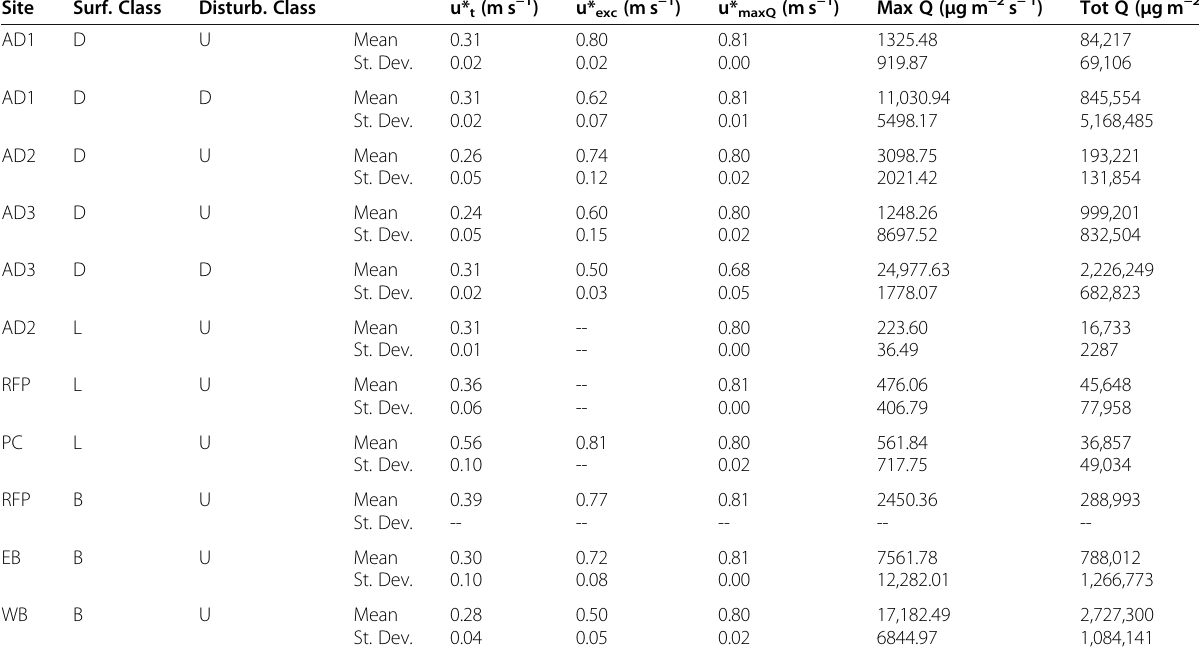
Table 3 Surface class (Delta, Lake, or Beach), disturbance class (Undisturbed or Disturbed), and mean and standard deviation of threshold friction velocity (u* t ), friction velocity at which the NAAQS standard would be exceeded in a 30 m tall column of air (u* exc ), friction velocity at which the maximum rate of PM 10 vertical flux is observed (u* maxQ ), the maximum rate of PM10 vertical flux observed (Max Q), and the total PM 10 vertical flux for the nine minute PI-SWERL test (Tot Q) of each sample